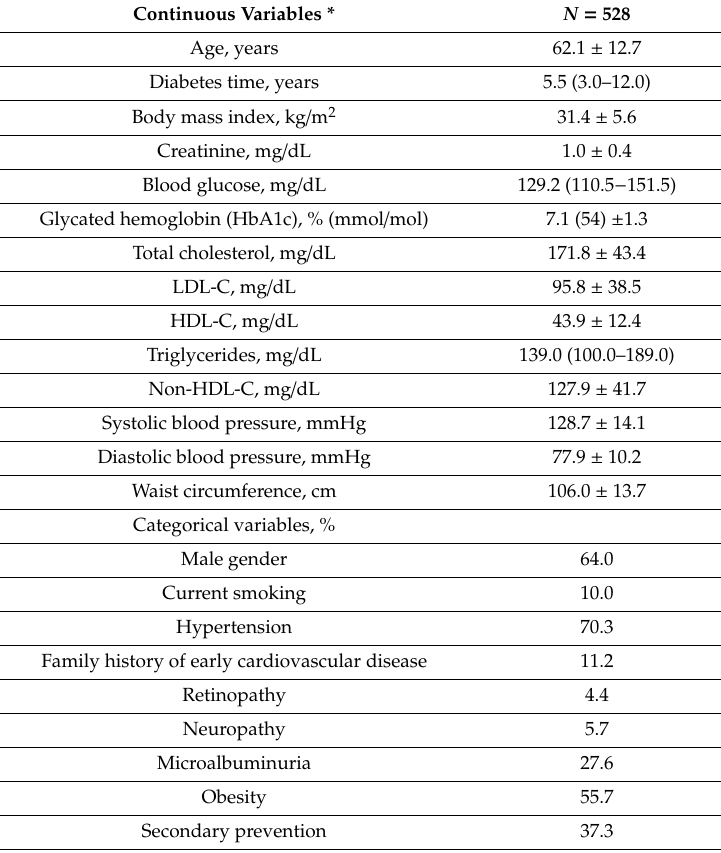
Table 1. Characteristics of the